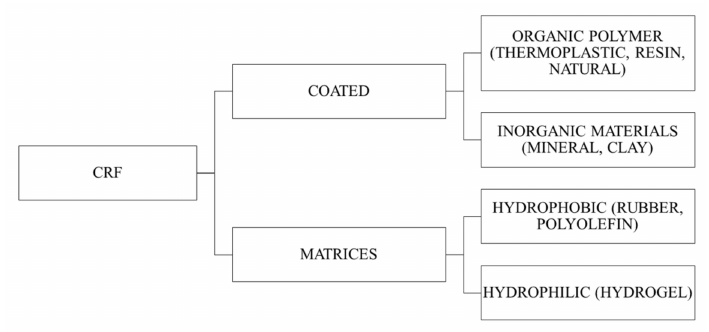
Figure 2. Simplified classification of controlled release fertilizers